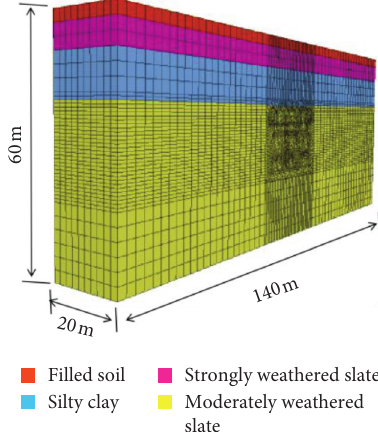
Figure 6: Stress-strain curve of moderately weathered slate. Table 1: Material properties.